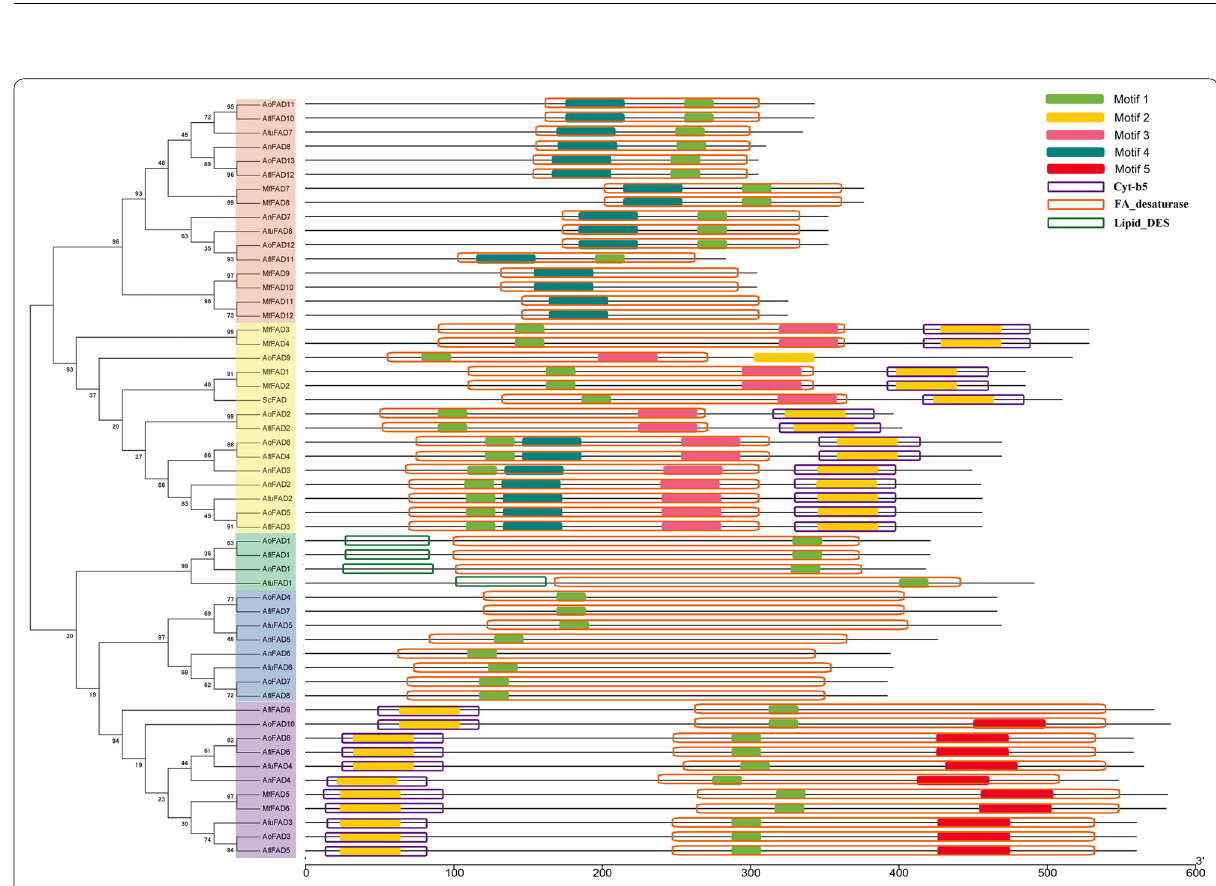
Fig. 2 Motif analysis of fatty acid desaturases gene family of the six species. Motif compositions: protein sequences are indicated by thick gray lines, and the conserved motifs are represented by different colored boxes. The domains are displayed by different colored boxes without filling. The length (amino acids) of the protein and motif can be estimated using the scale bar at the